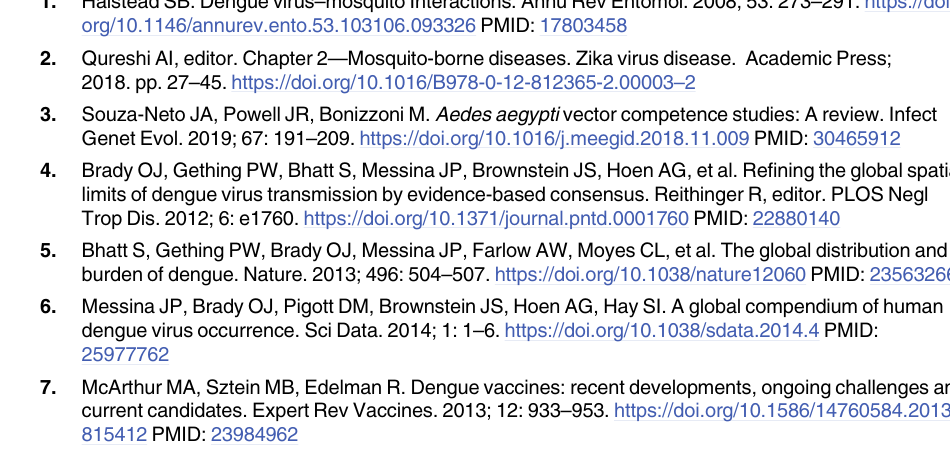
S3 Fig. Evidence of Wolbachia -mediated blocking of DENV for Fig 4. Average DENV loads for Wolbachia infected (D+ W+ ) and uninfected (D+W-). Data are pooled across the 6 repli- cate experiments. Graphs depict mean ± standard error. Loads are reduced in the presence of Wolbachia ( df = 115, F = 13.32, p <